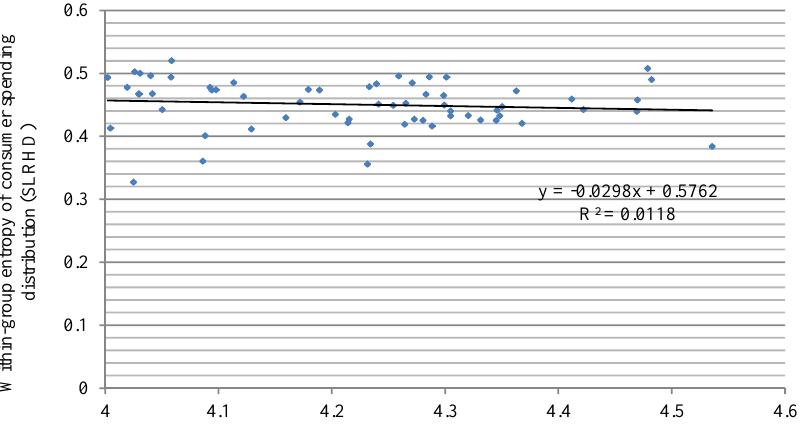
Figure 8. Linear regression for link "the absolute size of consumer spending — a measure of diversity of consumer spending (within-group entropy for SLRHD)" for 63 countries with highest household spending